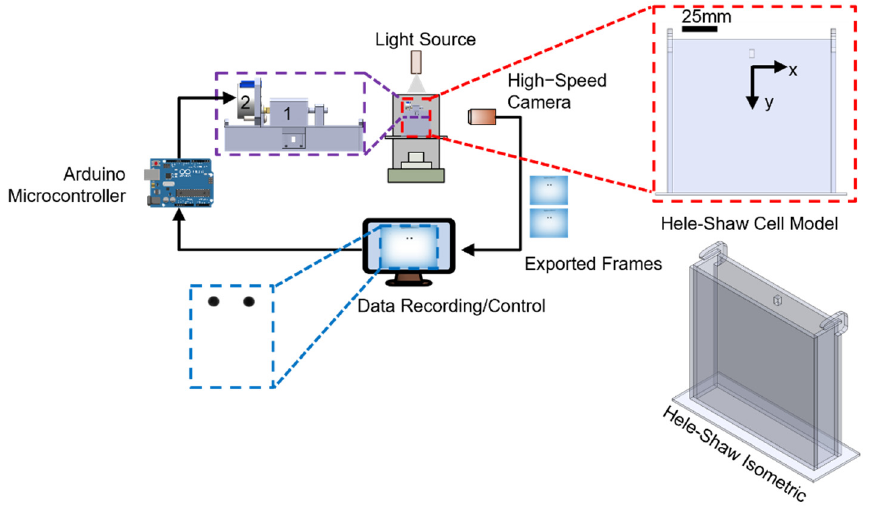
Figure 1. Schematic representing Hele-Shaw experimental apparatus. The particles were released from their initial location with the aid of a mechanical release system (#1) directly driven with a stepper motor (#2) and controlled with an Arduino microcontroller. High-speed imaging was utilized to map the positions of the particles in 2D space and time.